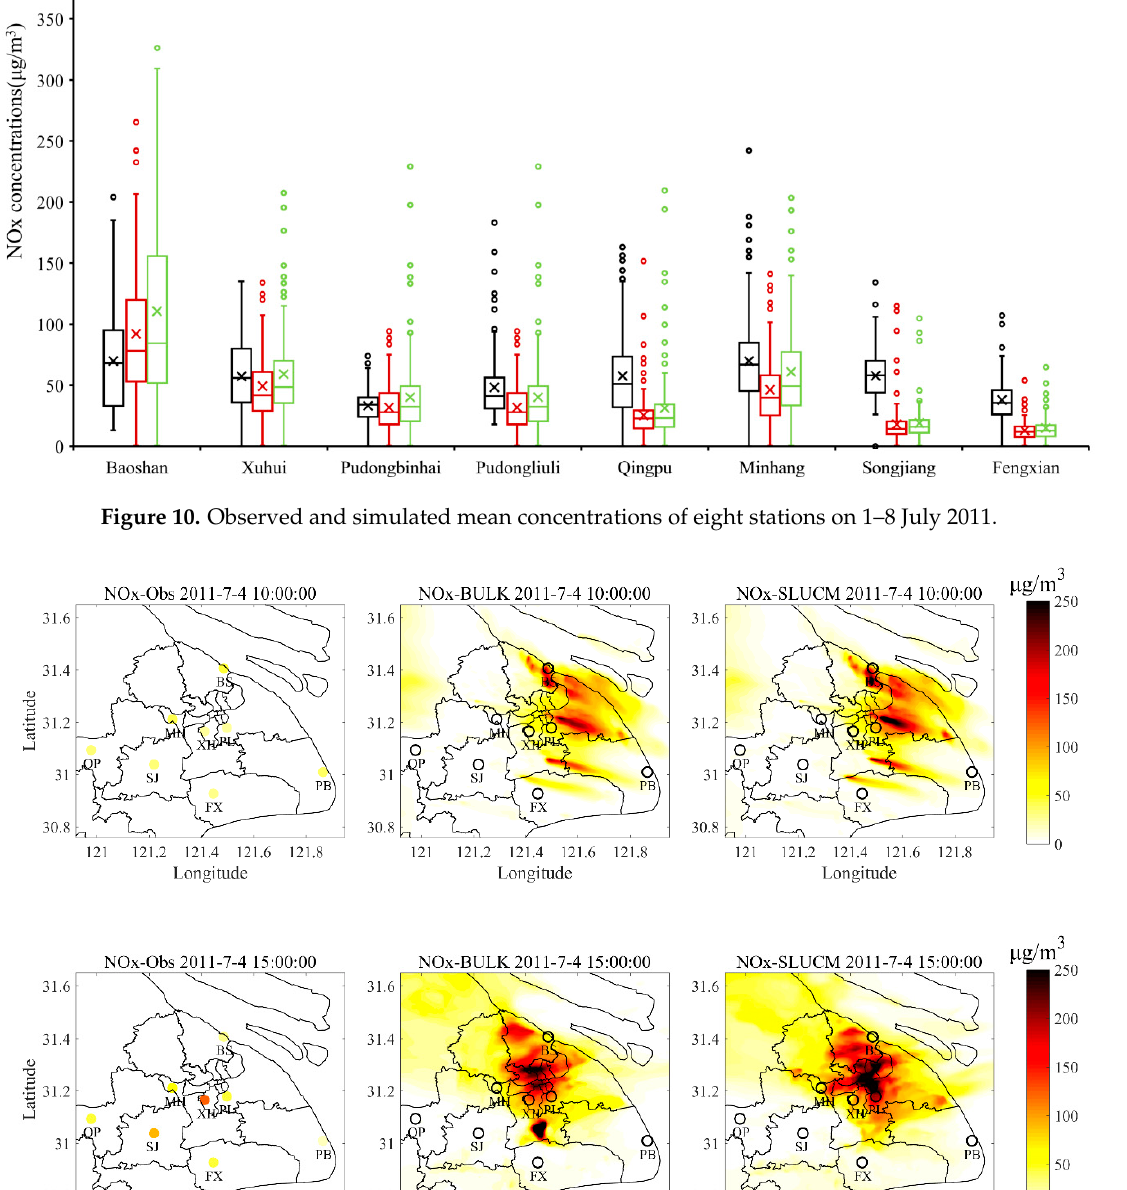
Figure 12. Time series of NO x concentration at Xuhui site on 3–5 July 2011. Red dash line: Cold front passing time. Figure 12 shows that the time series of NO x concentrations on 3–5 July. The results in Figure 12 show that the observed concentrations rose right before the arrival of the cold front and then declined continuously during the cold front. Due to the northerly wind, the cold front was coming from the north of Shanghai, where the Baoshan site is located. NO x concentration declined with the cold front arrival at 10:00 a.m. Simultaneously, the area influenced by the northerly winds expanded with the moving of the cold front. The Xuhui site was directly downstream from the cold front at this moment;